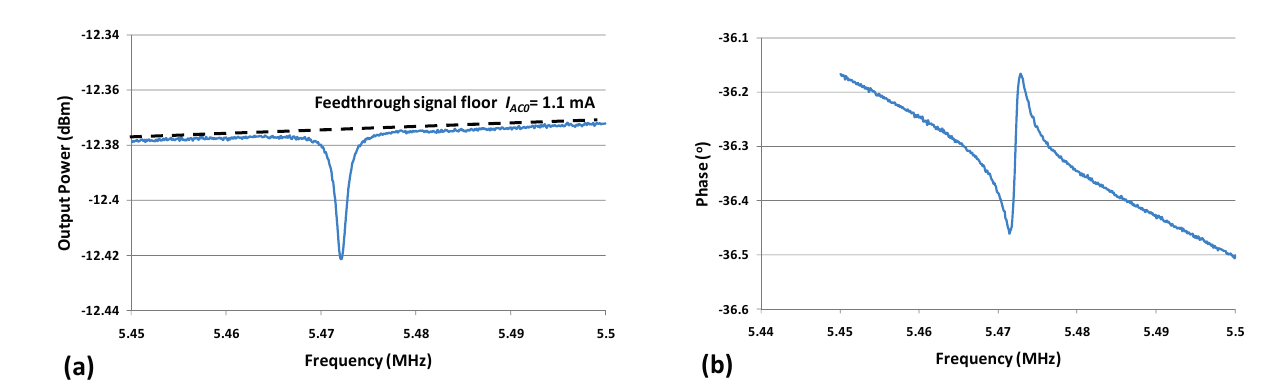
Figure 6. Output signal amplitude ( a ) and phase ( b ) versus frequency with input power of 10 dBm (equals to V AC of 1.4 V). ( V DC = 3 V, Measurement bandwidth = 100